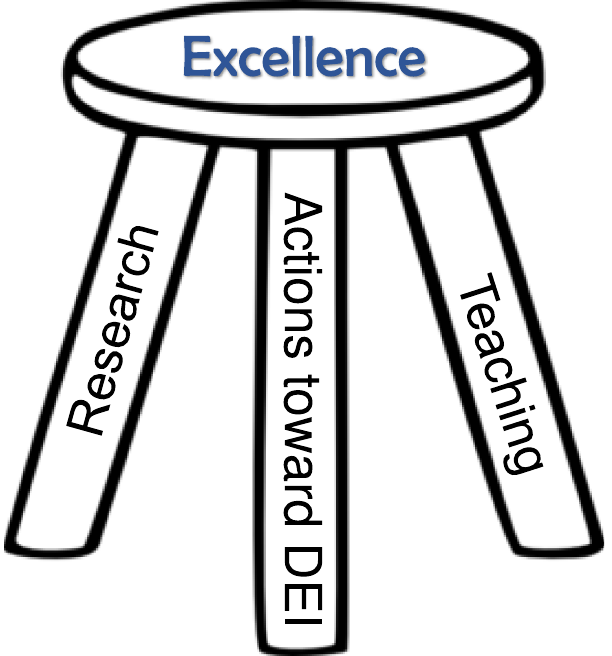
Fig. 2 Evaluation of applicants used a three-pronged approach. We equally valued Research, Teaching, and Actions toward Diversity, Equity, and Inclusion (DEI) as supporting the Excellence we were seeking in candidates. We scored each of these categories in our initial evaluation of 585 completed applications consisting of a cover letter (CV), research, teaching, and DEI statements as well as recommendation